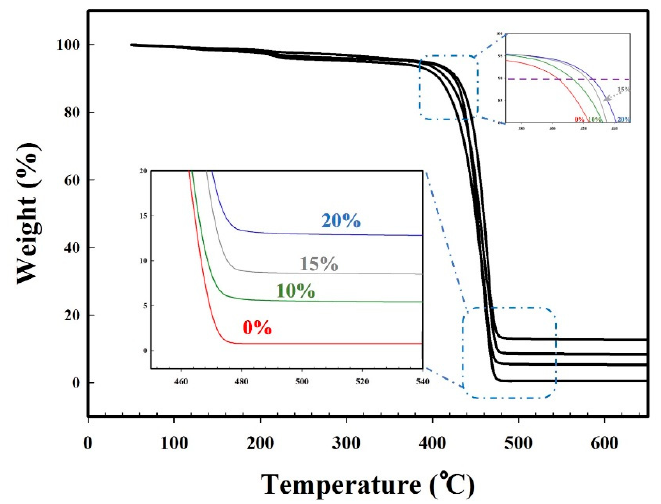
Figure 20. Thermogravimetric analysis (TGA) curves of MMFM samples compared to unfoamed